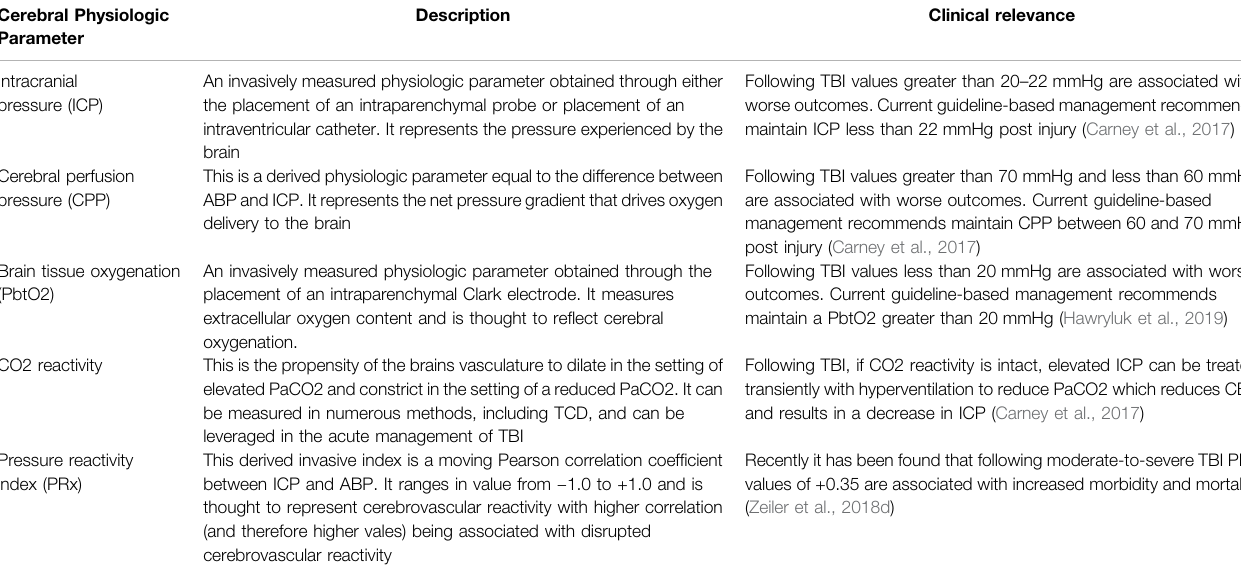
TABLE 2 | Outline of Cerebral Physiologic Parameters of Interest Cerebral Physiologic